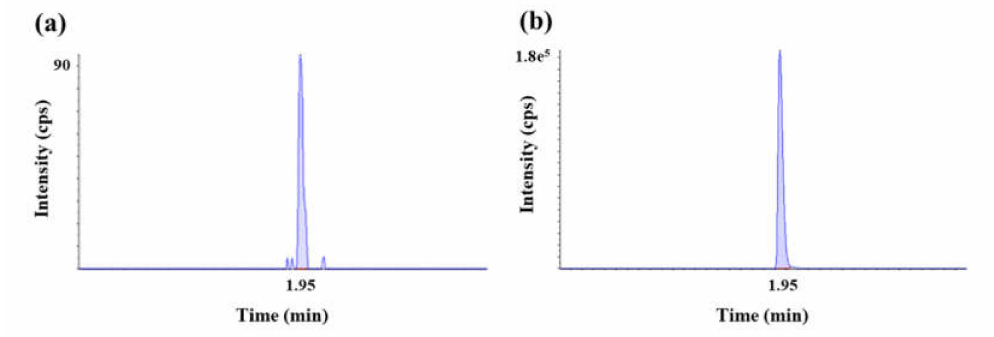
Figure 2. Representative chromatograms of ( a ) LLOQ (19.17 ng / mL) and ( b ) high QC (479.33 ng / mL) for acDrug (MMAF) in rat plasma.